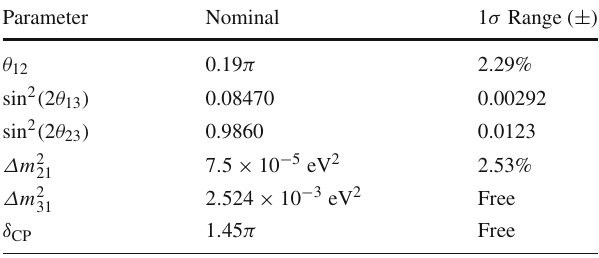
Table 4 Oscillation parameters and priors implemented in MCMC for calculation of Fig. 7 Parameter